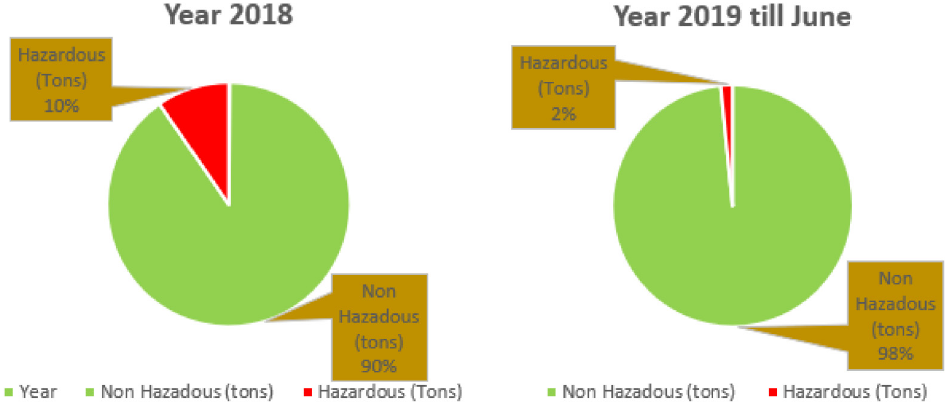
Fig. 3. Comparison of waste accumulation in Ajman (2018 – 2019) [6].